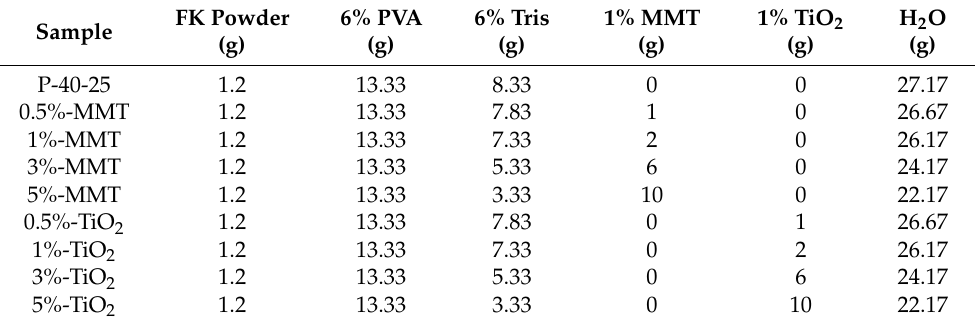
Table 1. Compositions of the different samples of blend